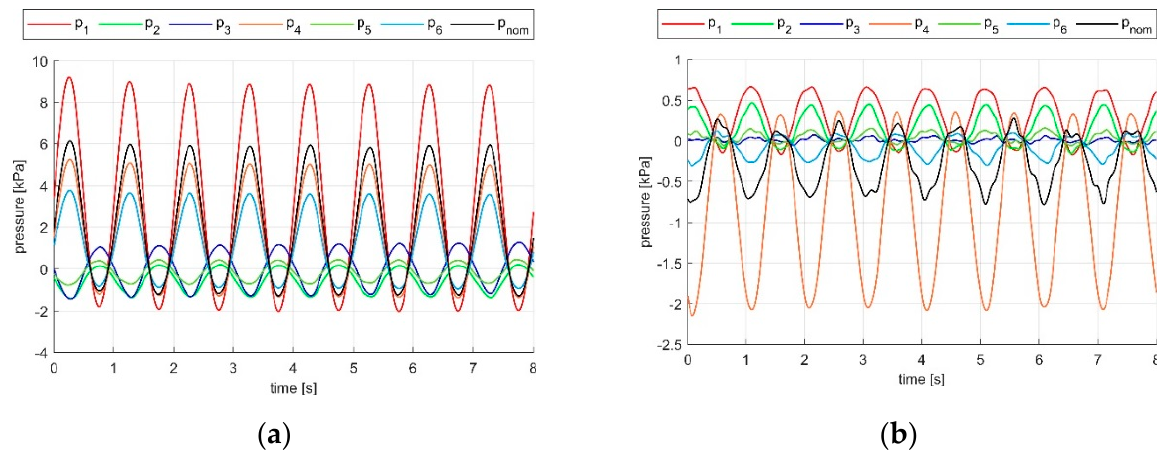
Figure 10. Raw outputs of sensors compared to the nominal load applied (in black): ( a ) Compression test along X. ( b ) Shear in direction XY. Table 1. Sensitivity coefficients: ratio between each sensor output (positive in compression) and nominal load (positive in traction) for the six tested load conditions.